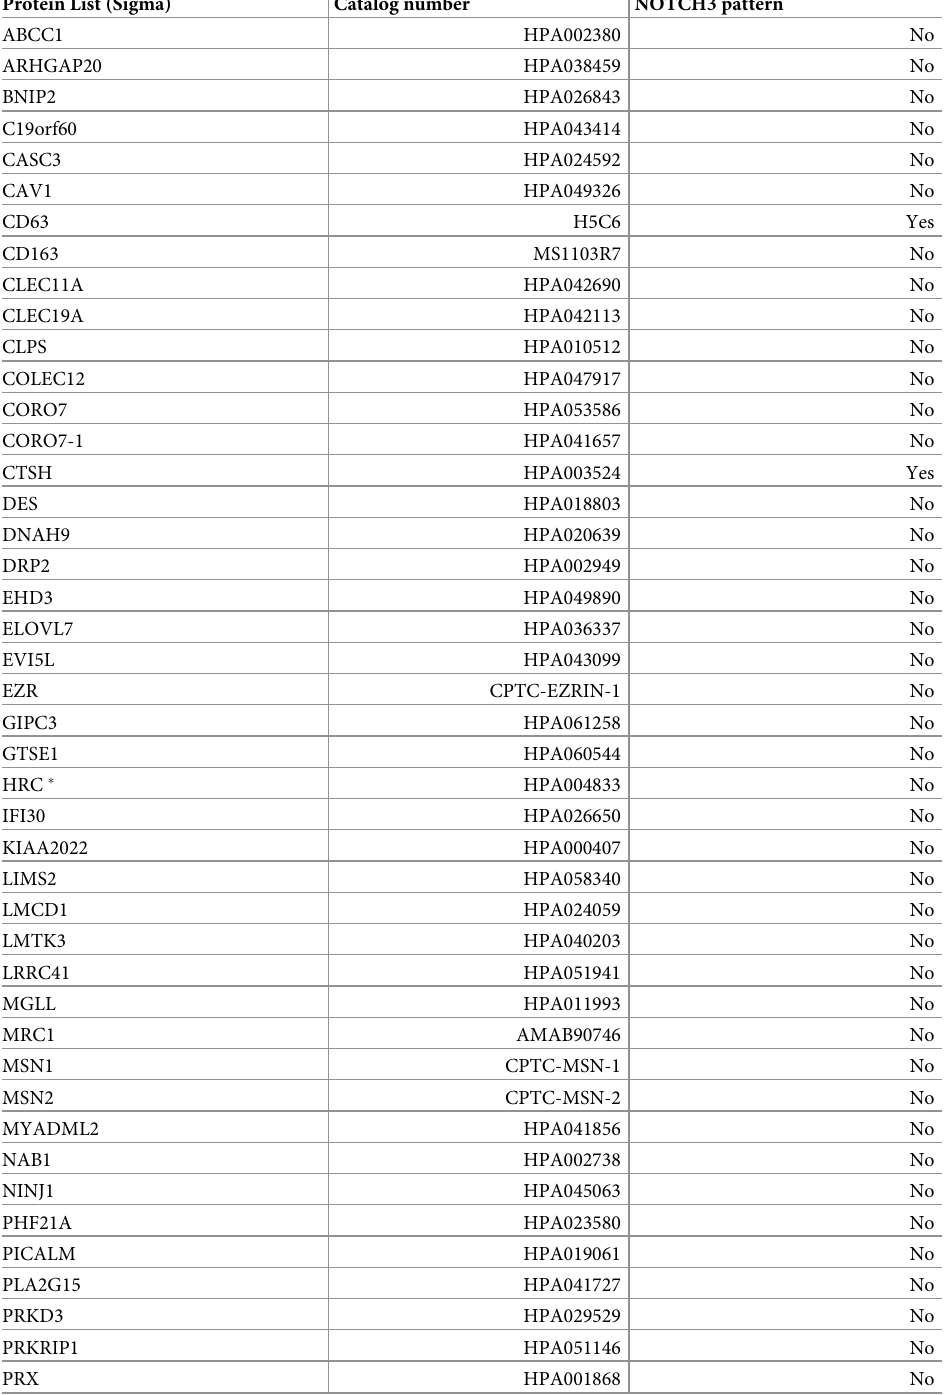
Table 2. Antibodies against proteins used in phase 2 screen for NOTCH3-like vascular markers in CADASIL. Protein targets are listed alongside antibody catalogue numbers as annotated in the Human Protein Atlas or listed in the Developmental Studies Hybridoma Bank. The presence of a NOTCH3 staining pattern is listed (defined as pre- dominantly medial and enriched in CADASIL arteries). � Two antibodies were delisted from the Human Protein Atlas since the initiation of the